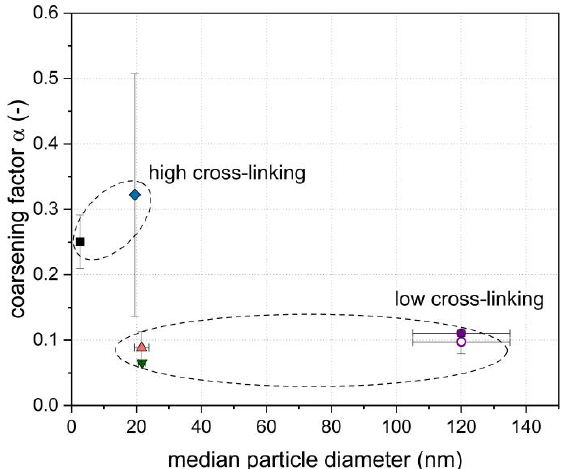
Figure 4. Coarsening factor α in dependence of the median particle size as a function of the cross- linking degree ( ▼ 85, ▲ 92, ● / ○ 104, ◆ 109, and ■ 120%; c particles : 8.2 g L − 1 ). Error bars indicate standard deviation.